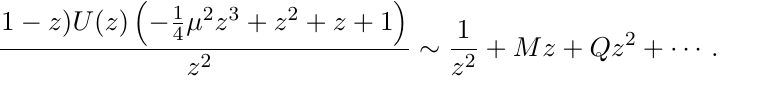
black brane [52, 53]. The mass density of the black brane can be obtained by using the AdS asymptotic behavior of g in our tt